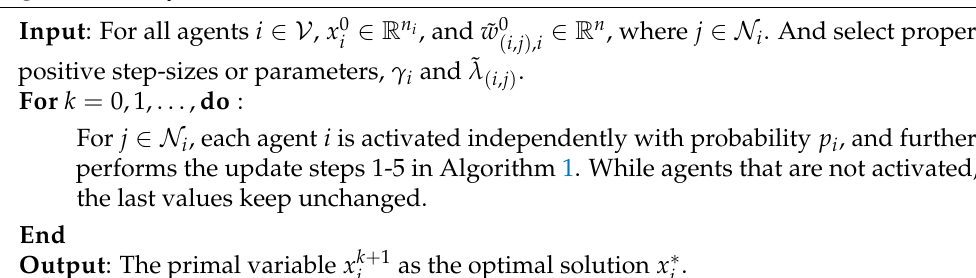
Algorithm 2 Asynchronous distributed